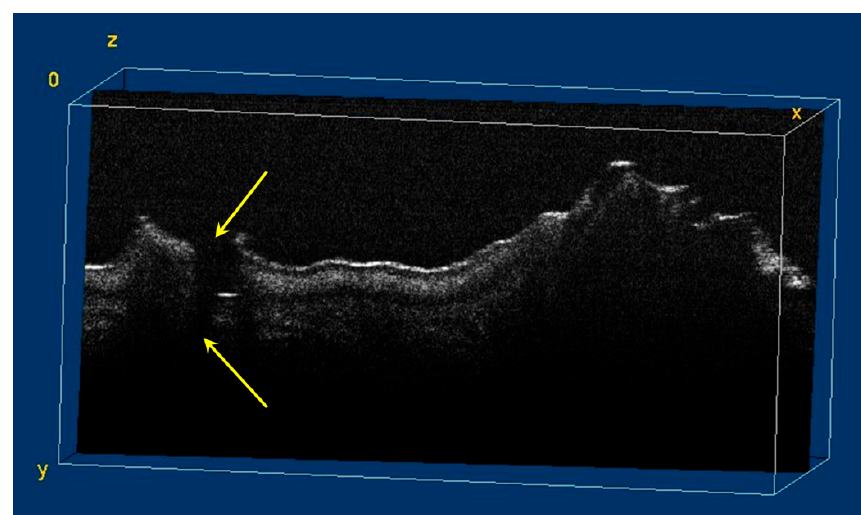
Figure 9. Volumetric reconstruction (in ImageJ) of a hypoplasia lesion. The yellow arrows indicate the affected area, defined by a discontinuity of the enamel at the surface of the tooth; this lesion extends beyond the dentinoenamel junction.